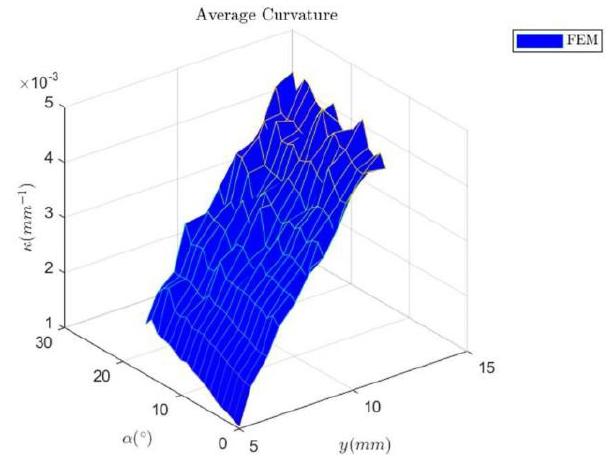
Figure 3. Average curvature against different combinations of 𝛼 and 𝑦 .